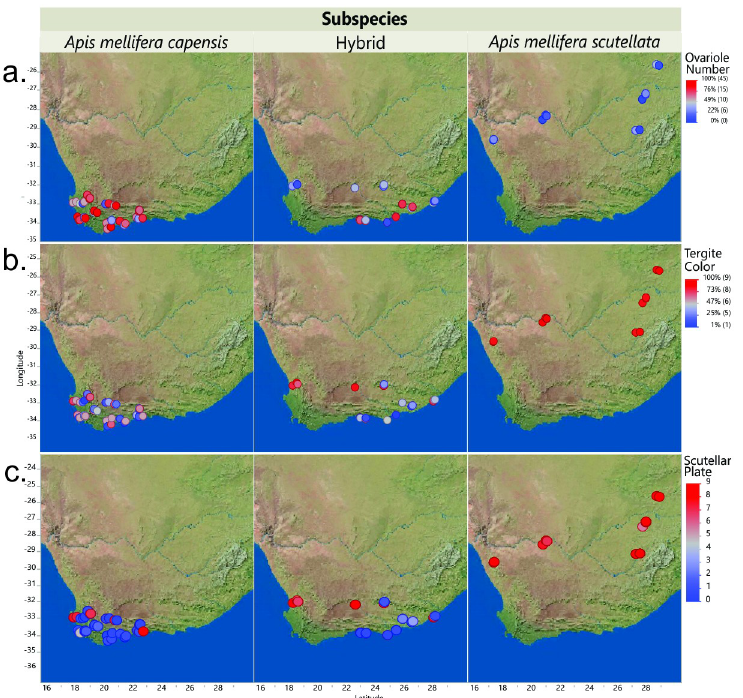
Fig 4. Distribution of morphometric phenotypic traits per subspecies, representing a. Ovariole Number quantile, b. Tergite Color quantile and c. Scutellar Plate color ranking. Red represents increased number of ovarioles (a) or lighter phenotypes (b and c), while blue represents lower number of ovarioles (a) and darker phenotypes (b and c). The visual distribution seems to correlate to the subspecies or hybrid geographical